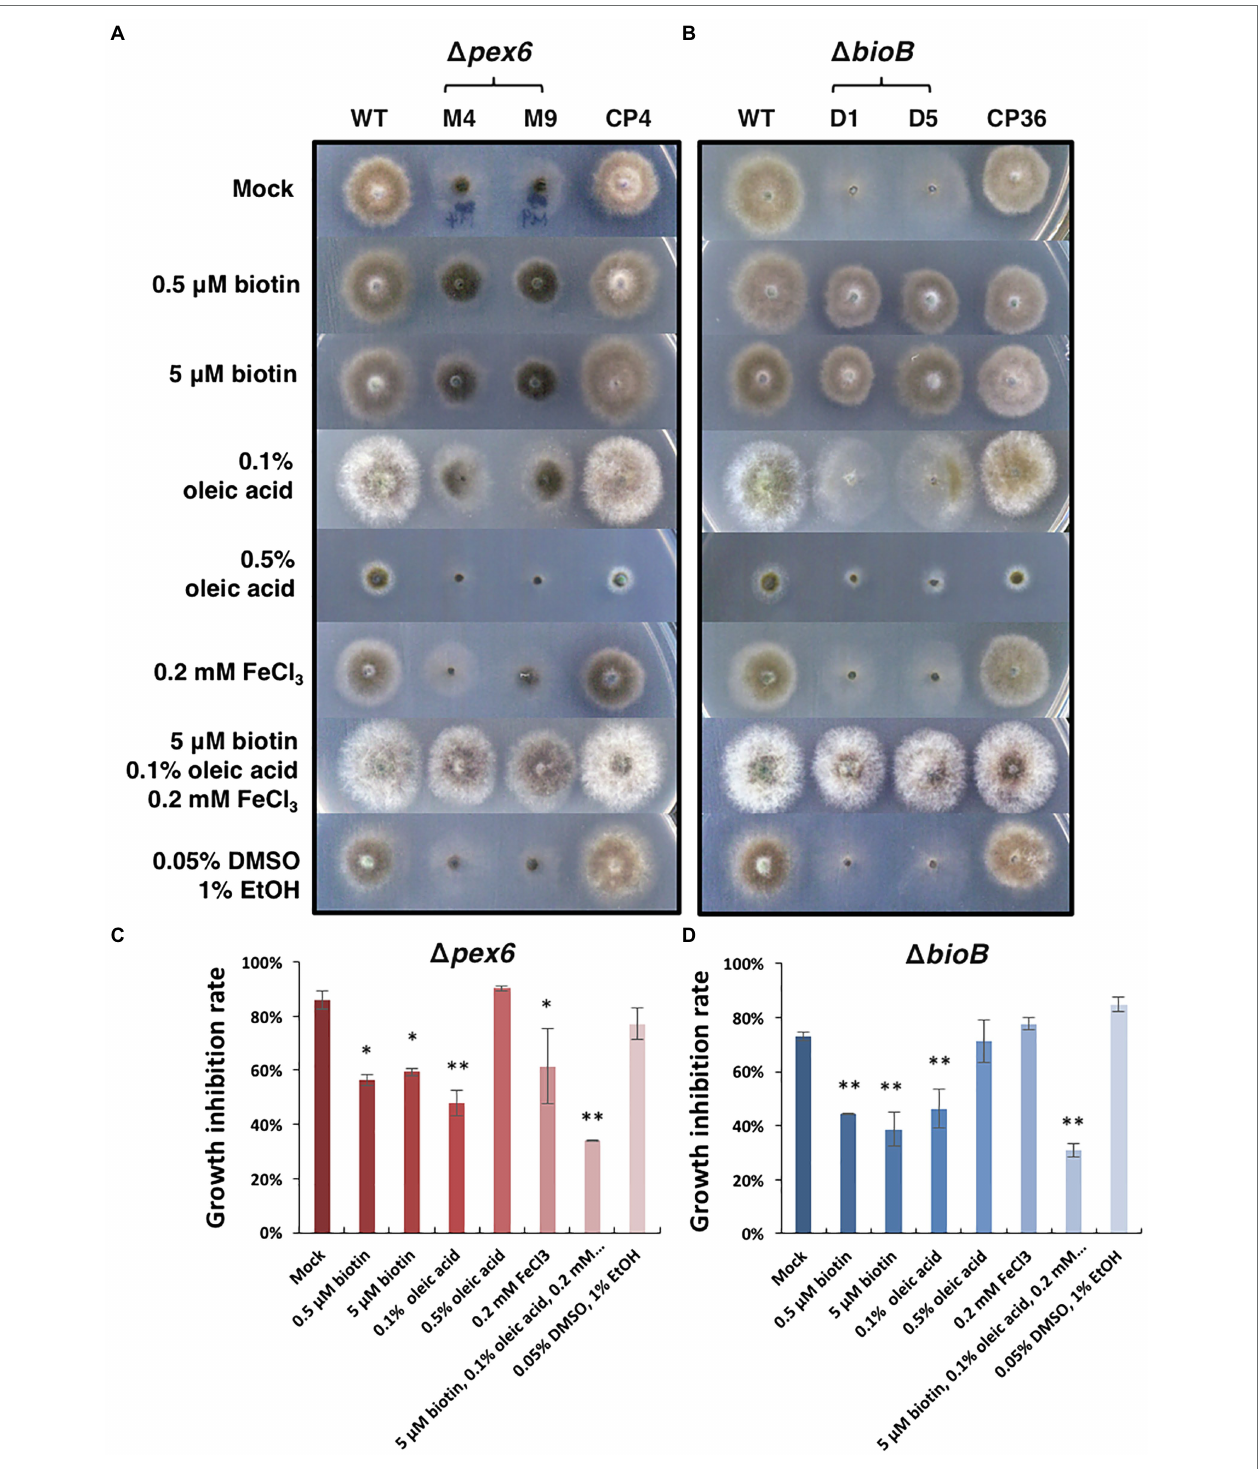
FIGURE 6 | Effects of biotin, oleic acid, and iron on the growth of A. alternata strains. (A) Growth of the wild-type (WT), the pex6 -deficient ( ∆ pex6 -M4 and M9), and the CP4 complementation strains on minimal medium (mock) amended with biotin, oleic acid, and/or FeCl 3 for 3 days. A combination of biotin, oleic acid, and iron partially restores growth deficiency of Δ pex6 . (B) Growth of the wild-type and the bioB -deficient strains ( ∆ bioB -D1 and D5) mutated at the biotin synthase (BioB)- coding gene, and the CP36 complementation strain on minimal medium amended with or without biotin, oleic acid, and/or iron. Biotin was dissolved in 10% DMSO, and oleic acid dissolved in 95% ethanol (EtOH). Quantitative analysis of growth reduction of Δ pex6 (C) and Δ bioB (D) in relation to WT. Means indicated by asterisks are significantly different from the mock control, ** p < 0.01, and * p <